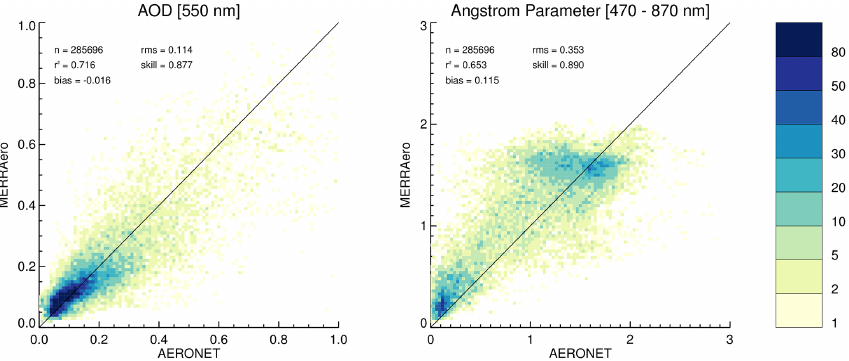
Figure 2. AOT (left) and AE (right) comparisons between MERRAero and AERONET hourly observations (20 ◦ S–45 ◦ N; 100 ◦ W–60 ◦ E) for July 2009. The number of comparisons at each AERONET station is indicated by the color